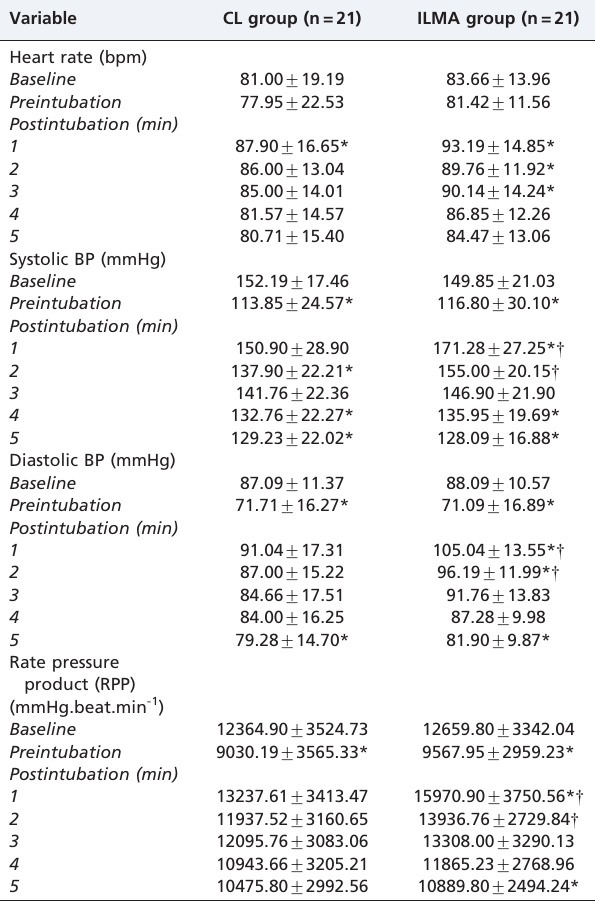
Table 2 - Hemodynamic parameters of the groups.